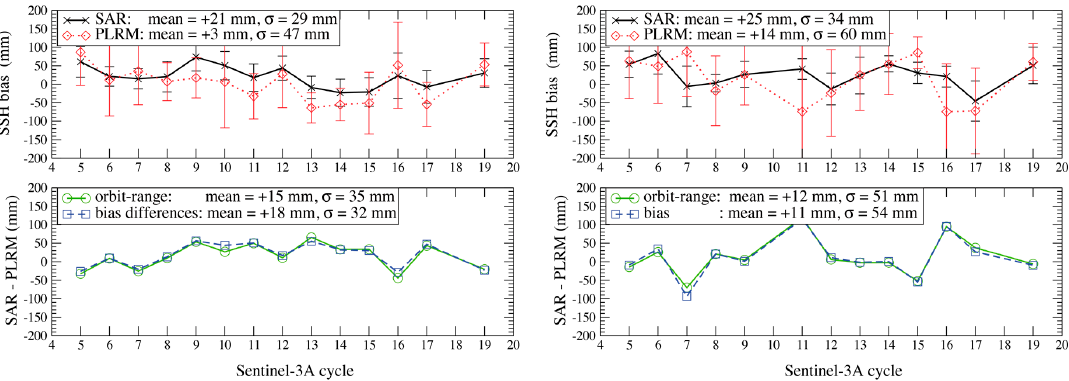
Figure 6. Sentinel-3A SSH bias time series from Senetosa ( left ) and Ajaccio ( right ). The upper panels show the time series for SAR (black crosses) and Pseudo LRM (PLRM) (red diamonds). The lower panels show the differences between SAR and PLRM for the “orbit-range” (green circles) and the total SSH bias (blue squares).